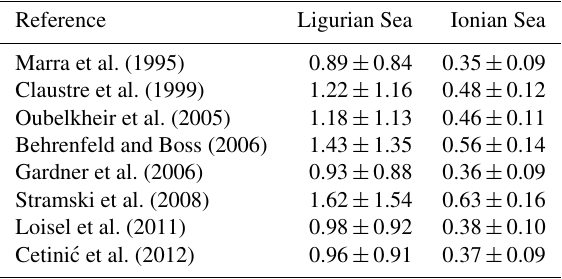
Table 5. Comparison of the mean rates ± SD (gCm − 2 d − 1 ) of the community production integrated within the euphotic layer, derived from the application of the bio-optical diel-cycle-based method to the c p measurements, using different bio-optical relationships from the literature for converting the c p values into POC